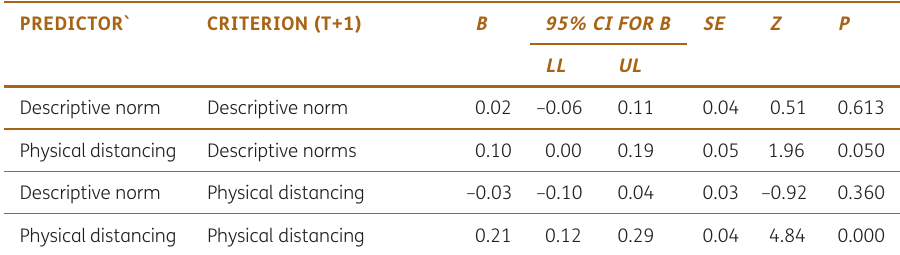
Table 11 Random Intercept Cross-lagged Panel Model for the University Sample. Note : N =